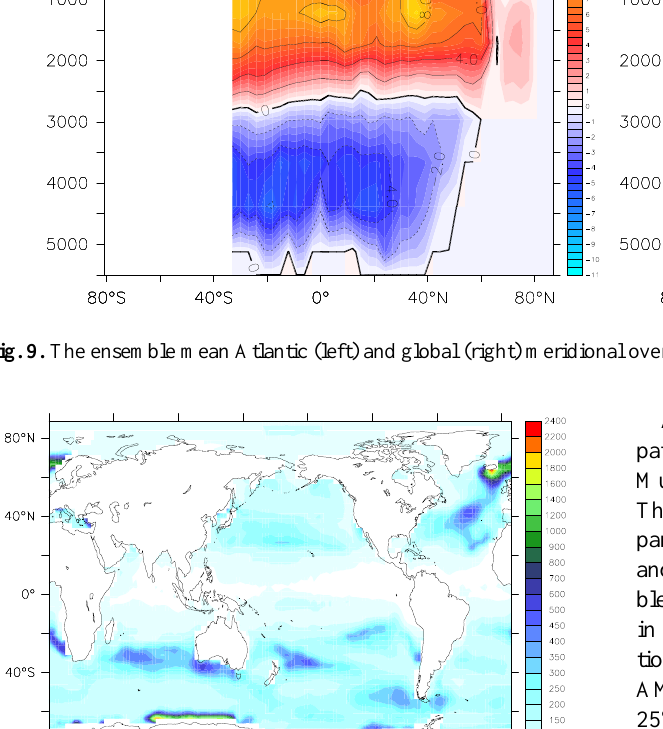
Fig. 9. The ensemble mean Atlantic (left) and global (right) meridional overturning circulation in Sv in SPEEDO.